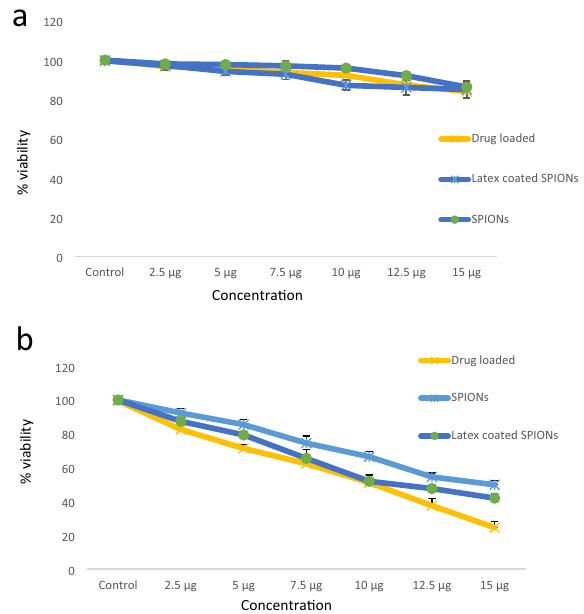
Figure 12. MTT assay against ( a ) normal fibroblast L929 cells ( b ) breast cancer MDA-MB-231 cell